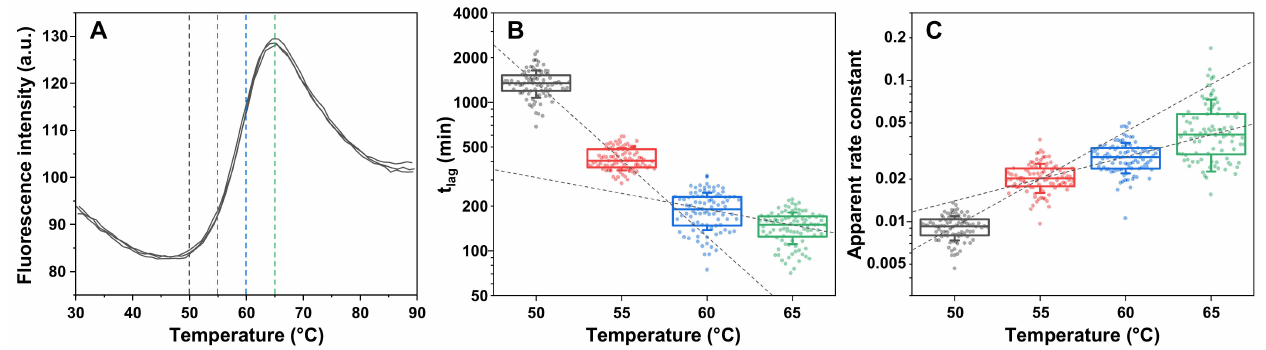
Figure 1. Lysozyme aggregation kinetic parameters depended on folding state. 8-anilinonaphthalene- 1-sulfonic acid (ANS) signal intensity under a range of temperatures and in the presence of 200 µ M lysozyme in PBS with 2 M guanidine hydrochloride (GuHCl) (pH 7.4). ( A ) Colour-coded dashed lines indicate temperatures chosen for further analysis. Lysozyme aggregation reaction t lag ( B ) and apparent rate constant ( C ) values under the four selected temperature conditions (all data are colour- coded). Panel B and C box plots indicate the interquartile range and error bars are one standard deviation ( n = 96). ANS protein melt and aggregation assay procedures are described in the Materials and Methods section. Raw data are available as Supplementary